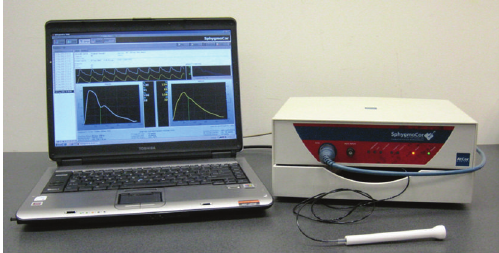
Figure 2: Electronics module (SphygmoCor device, AtCor Medical, Sydney,